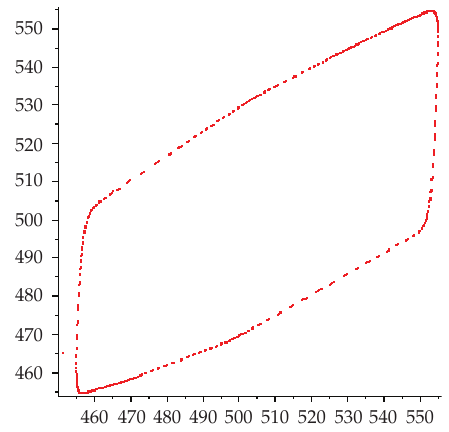
Figure 2: (cid:2) y (cid:2) t − 1 (cid:3) ,y (cid:2) t (cid:3)(cid:3) in the deterministic case for d (cid:7) 0.